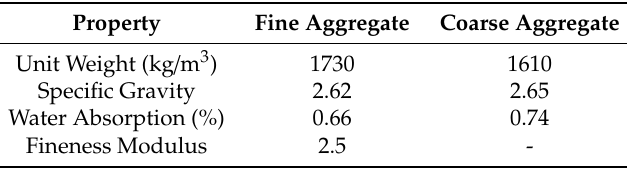
Table 2. Physical properties of